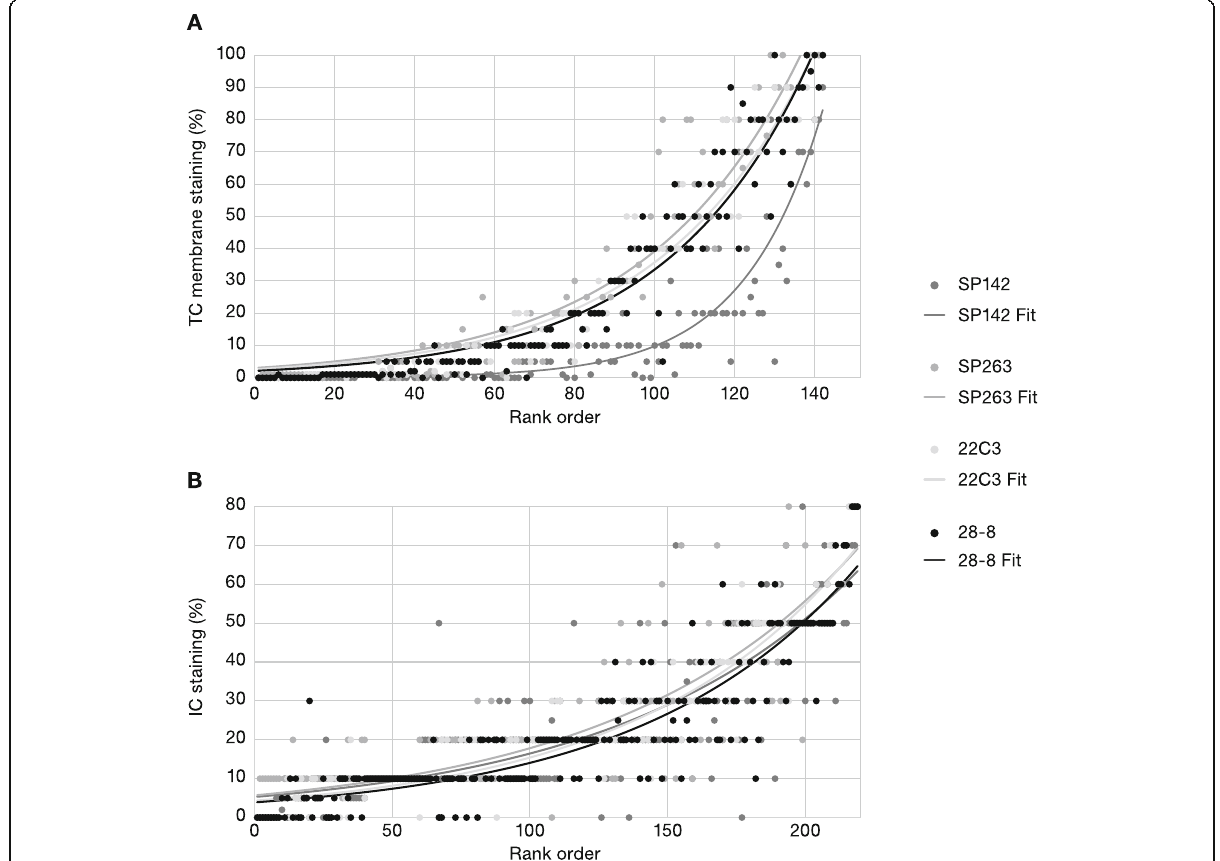
Fig. 3 Percentage of PD-L1 – positive TC and IC (per IC area) ranked by average value. Exponential fits to the data are provided for ease of visualization. a % of TC membrane staining ranked by average % of TC membrane staining. b % of IC membrane staining ranked by average % of